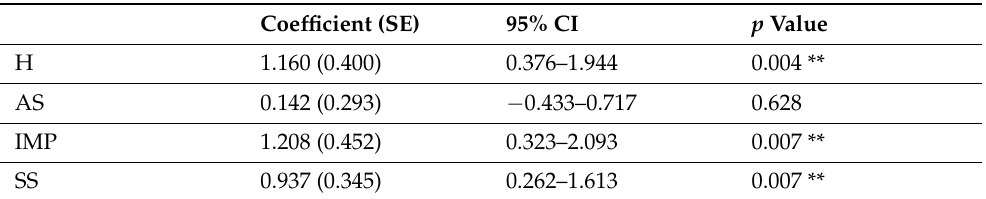
Table 3. Associations between personality groups at baseline and number of traumas experienced across adolescence. Coefficient (SE) 95% CI p Value H 1.160 (0.400) 0.376–1.944 AS 0.142 (0.293) − 0.433–0.717 IMP 1.208 (0.452)